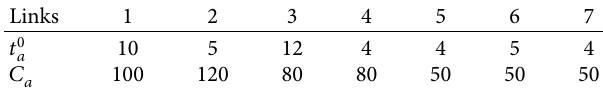
Table 1: Link characteristics of the example network in Figure 1.